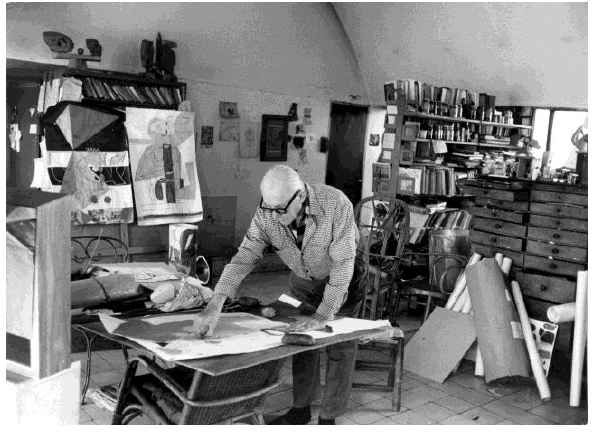
Figure 1. Le Corbusier in his atelier - © FLC-ADAGP